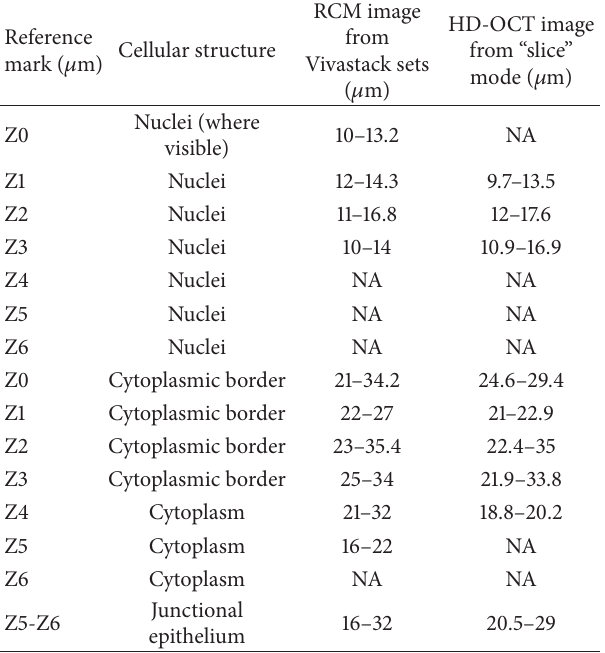
Table 4: Cellular features in lower lip mucosa evaluated in vivo by reflectance confocal microscopy and high-definition optical coherence tomography.